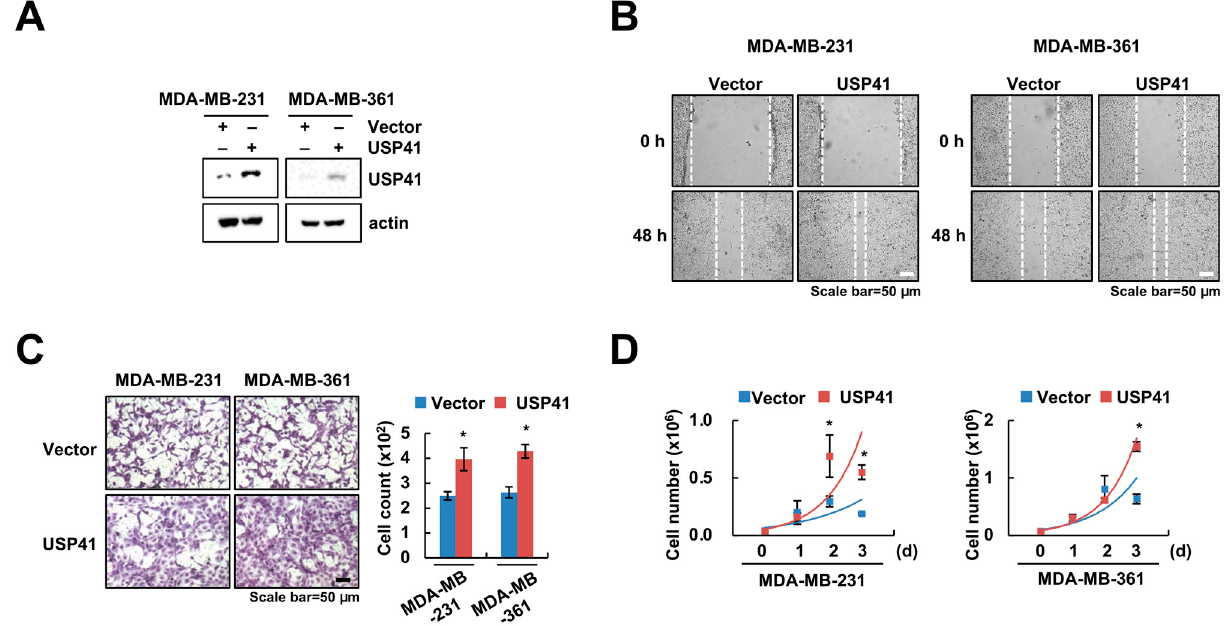
Figure 3. Overexpression of USP41 increases migration and proliferation of breast cancer cells. ( A – D ) MDA-MB-231 and MDA-MB-361 cells were transfected using vector and USP41 plasmid for 48 h. The protein levels of USP41 were examined by Western blotting ( A ). Migration ability was examined by wound healing assay ( B ) and transwell assay ( C ). Cell growth was determined by cell counting ( D ). The values in the graph represent the mean ± SD of three independent samples, respectively. * p < 0.05 compared to the vector.